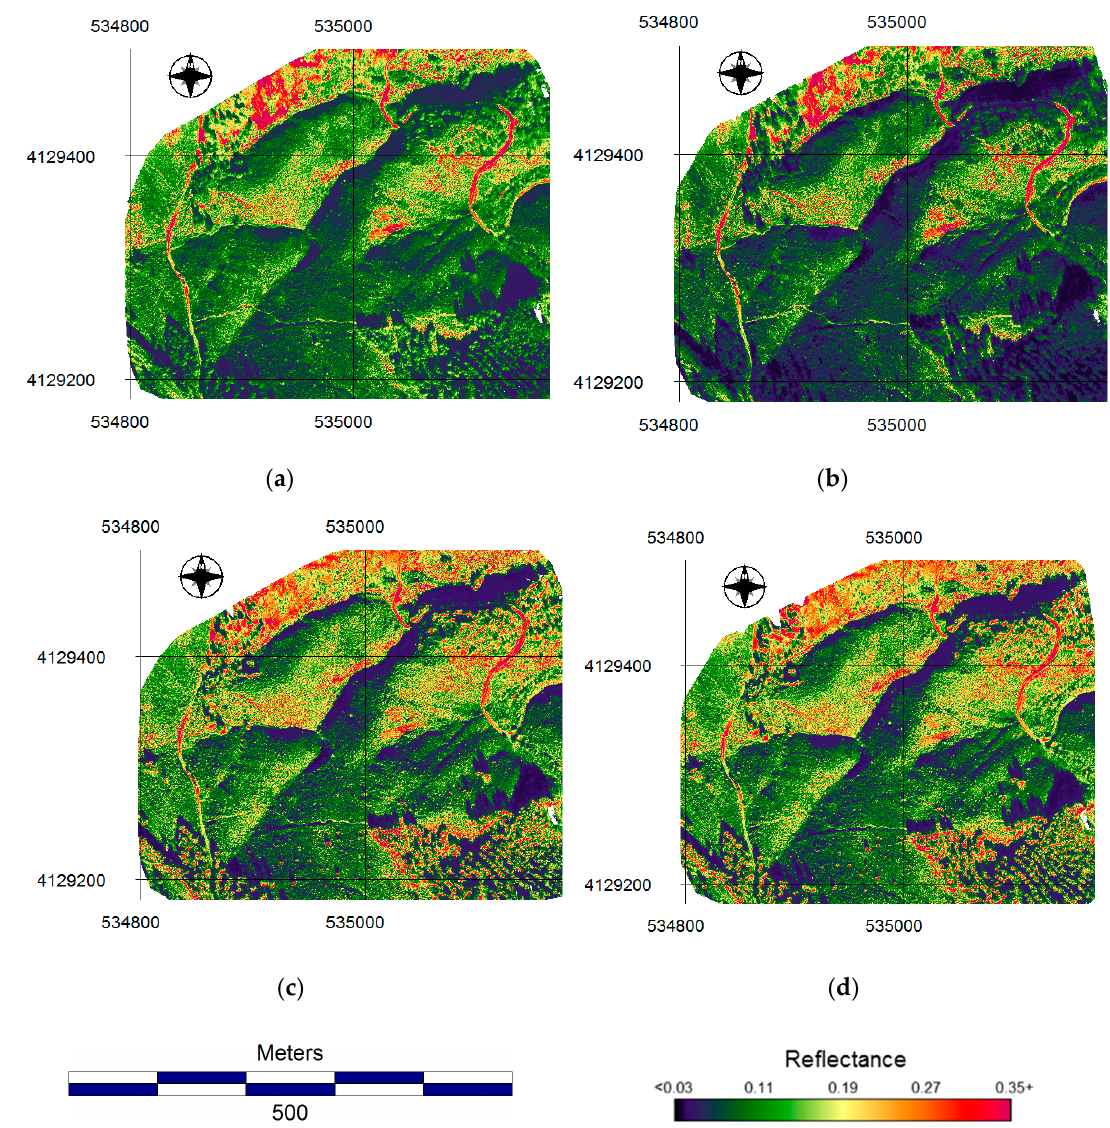
Figure 8. ( a ) Green, ( b ) red, ( c ) red edge, and ( d ) near-infrared (NIR) orthoimages corresponding to reflectance, represented in an eight-bits quantitative scale.